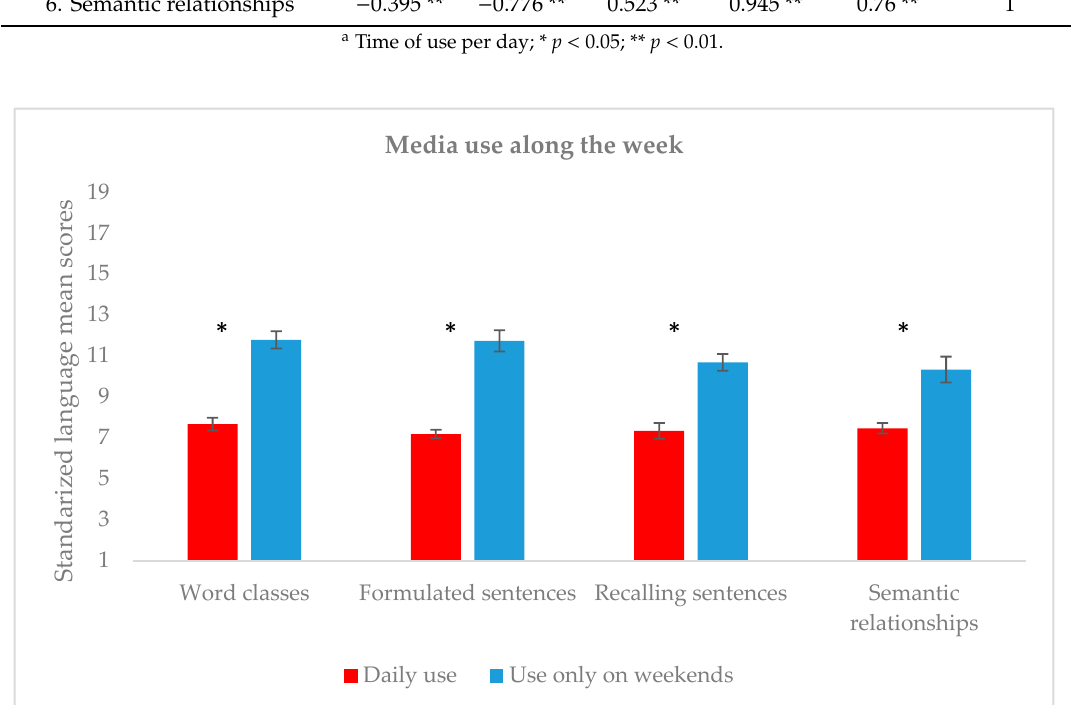
Figure 1 . Mean scores on language tasks and use of media along the week. * p < 0.001. Figure 1. Mean scores on language tasks and use of media along the week. * p <